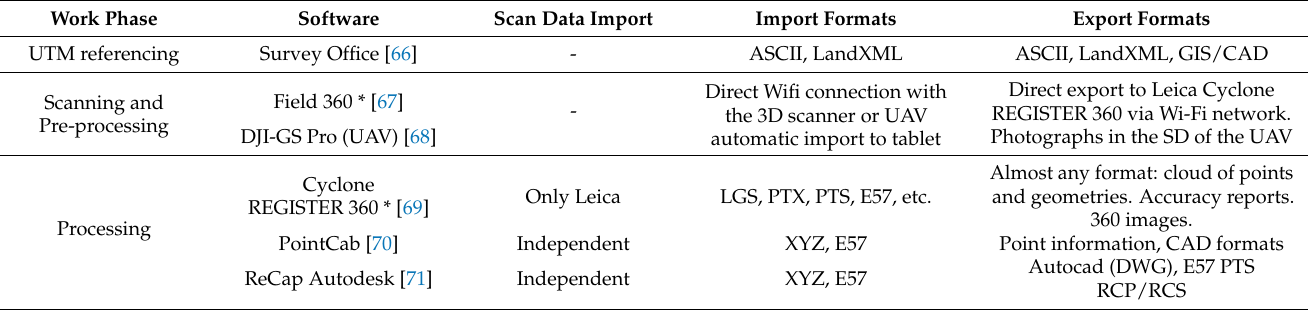
Table 4. Software used in the massive point